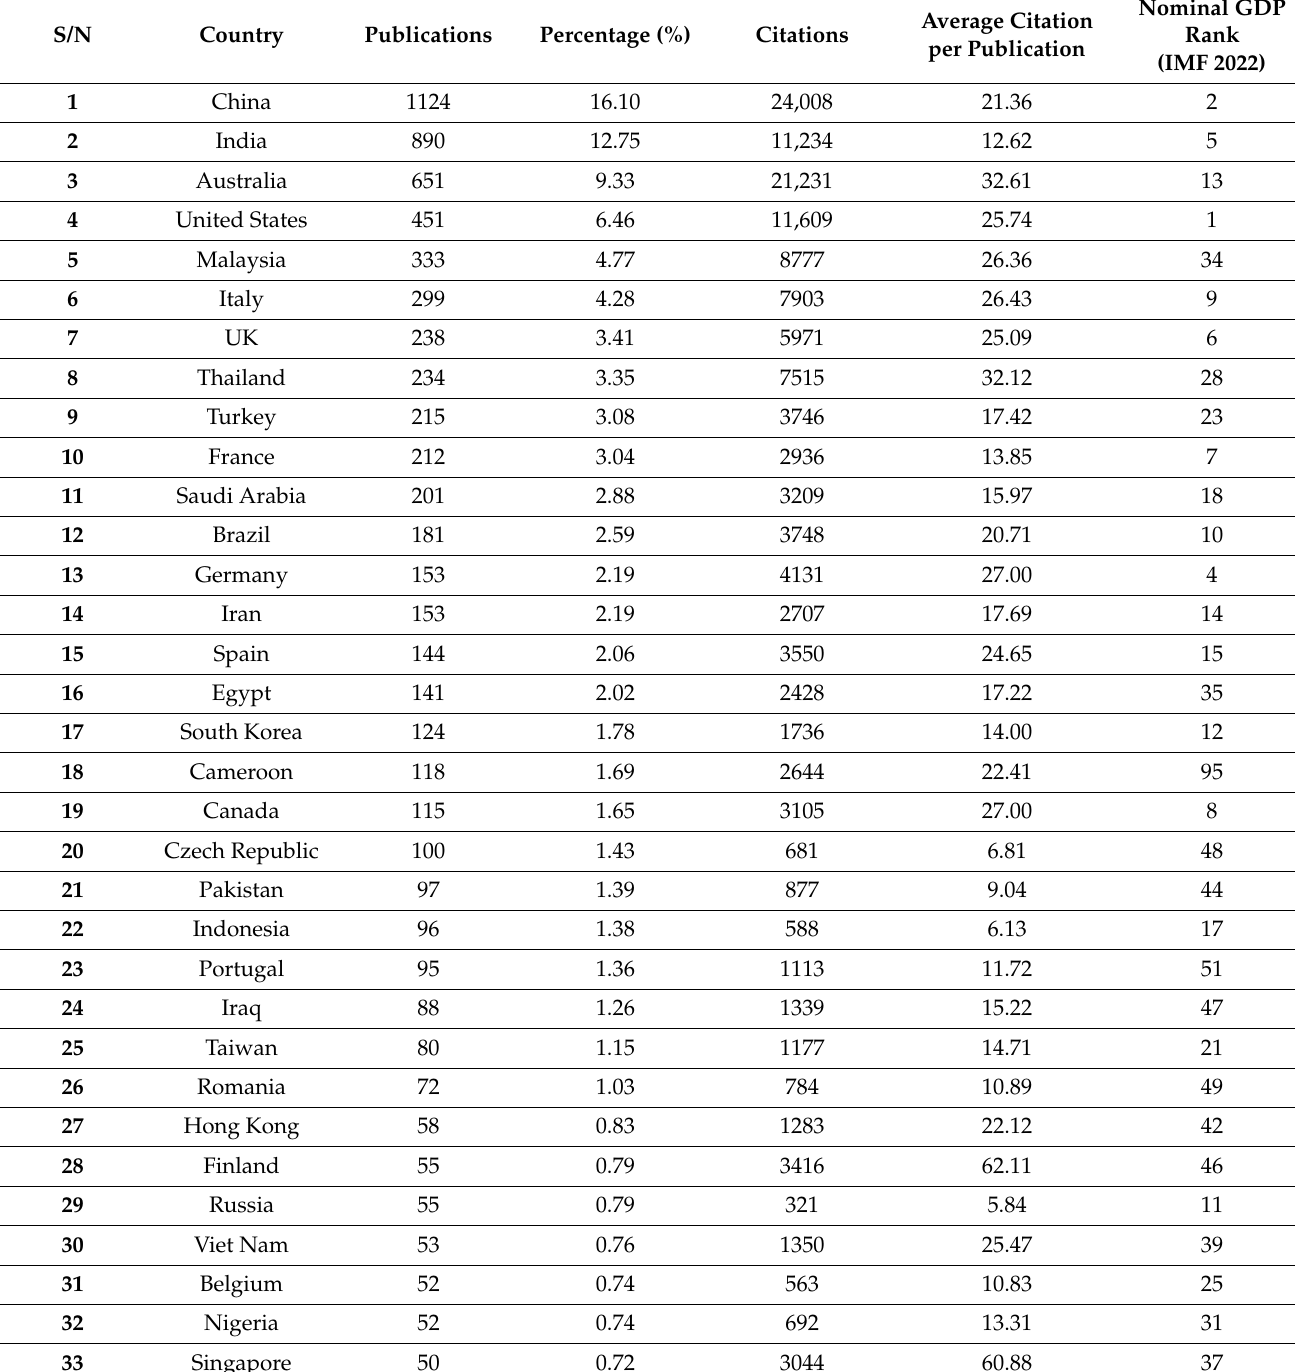
Table 7. Countries with a minimum of 50